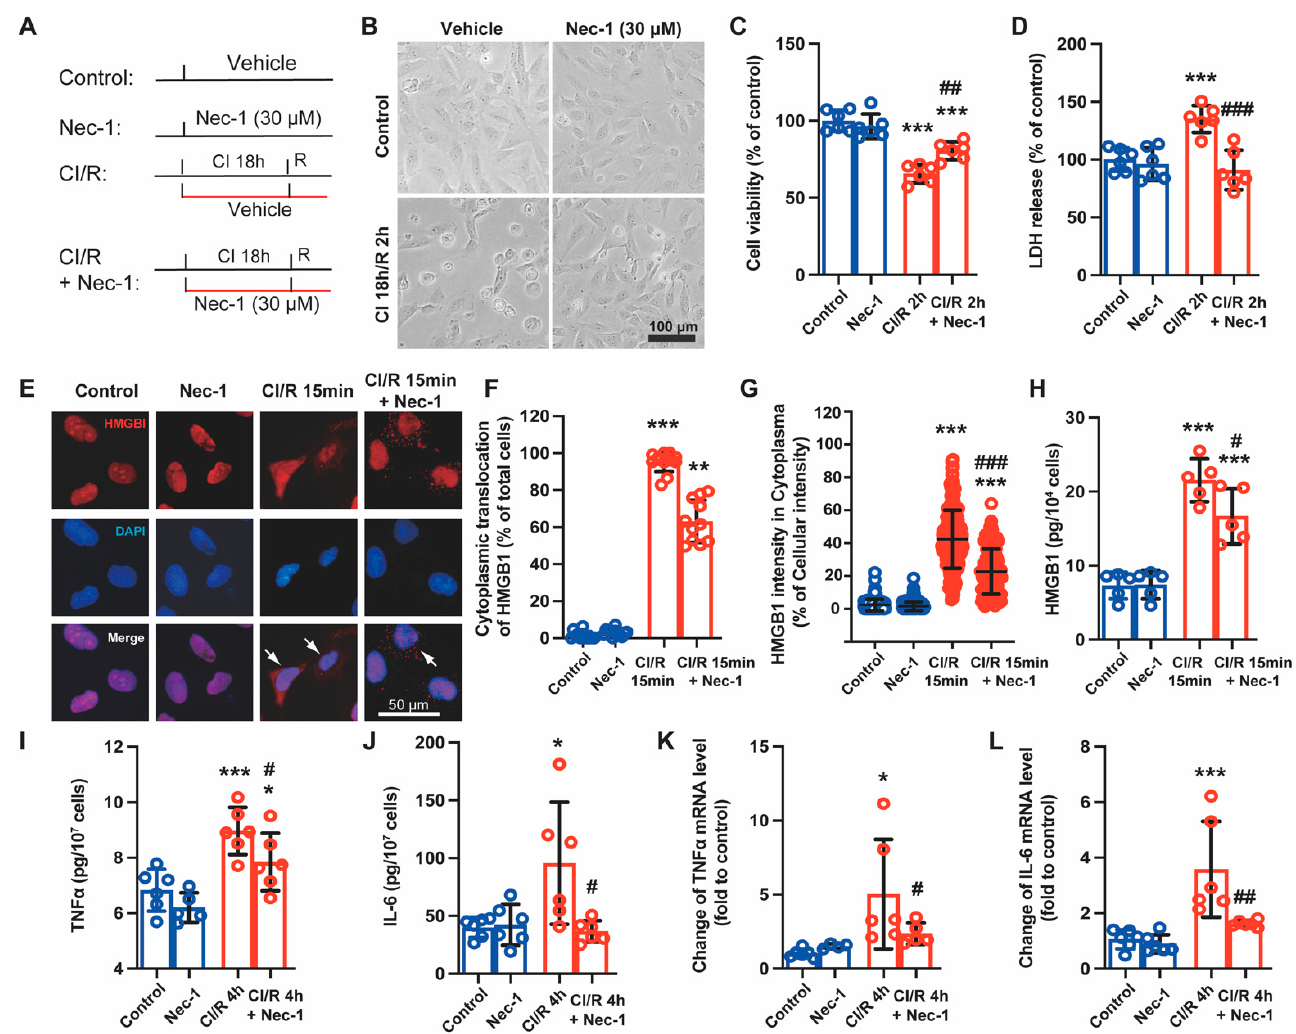
Figure 3. Necrostatin-1 mitigated cold ischemia and reperfusion (CI/R)-induced cell death and production of inflammatory cytokines in BEAS-2B cells. BEAS-2B cells were incubated in a 4 ◦ C chamber filled with 50% oxygen for 18 h with ice-cold lung preservation Perfadex ® solution to simu- late the procedure of clinical donor lung preservation and then subjected to a warm culture medium to mimic reperfusion. Necrostatin-1 (Nec-1, 30 µ M) was added to the medium at the beginning of cold-ischemia and sustained during reperfusion. ( A ) Cell experiment protocol. ( B ) Morphological changes of BEAS-2B cells in different groups. ( C ) Cell viability determined using trypan blue ex- clusive staining. ( D ) LDH in the cell culture medium. ( E ) The distribution of HMGB1 in the cells observed by immunofluorescent staining. ( F ) The counts of cells undergoing HMGB1 cytoplasmic translocation. The percentage of the cells with HMGB1 cytoplasmic translocation to total cells was calculated. ( G ) The percentage of the optical density of HMGB1 in the cytoplasm to that of the whole cell. ( H – J ) The level of HMGB1, TNF α and IL-6 in the cell culture supernatant determined using ELISA. ( K , L ) The mRNA level of TNF α and IL-6 detected using real-time PCR. Three independent experiments were performed. * p < 0.05, ** p < 0.01, *** p < 0.001, compared with Control; # p < 0.05, ## p < 0.01, ### p < 0.001, compared with CI/R. One-way ANOVA.